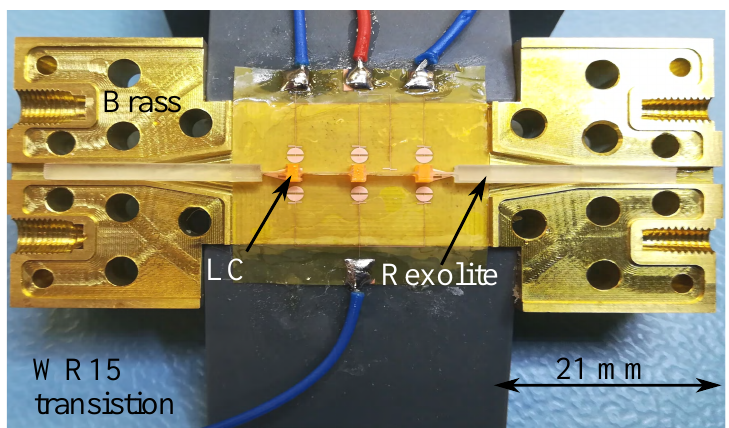
Figure 55. Photograph of the partially assembled tunable NRD bandpass filter.